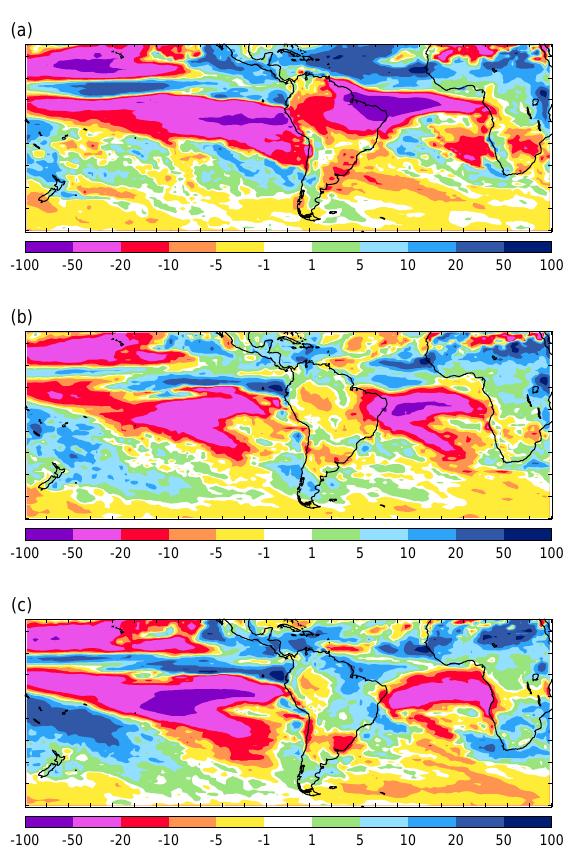
Fig. 9. (a) Percentage change in precipitation from the “ALL” case of Jones et al. (2009). (b) As (a) but for I-mask. (c) As (a) but for I-mask NSA .